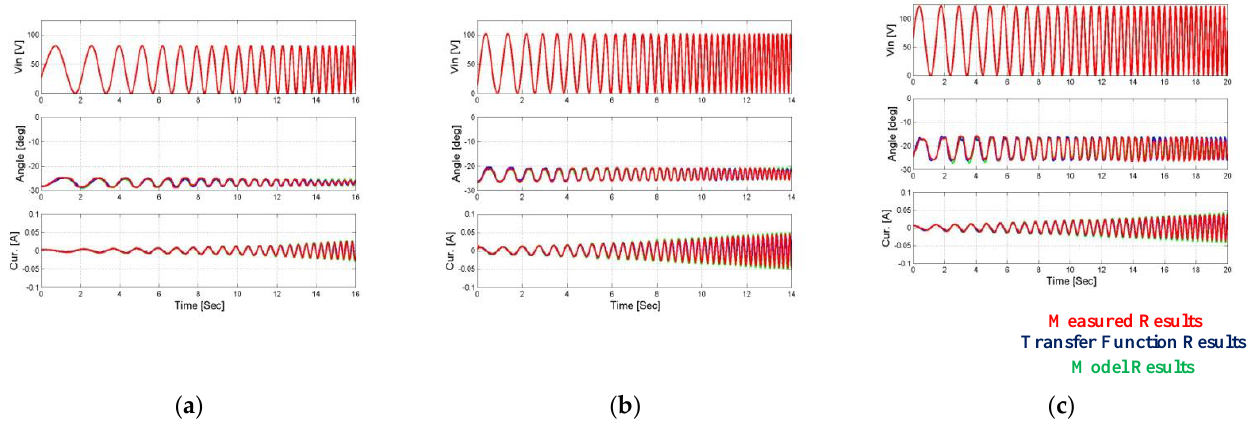
Figure 19. Comparison of uniform transfer function results ’ model results vs. measured output results when the second load is applied. ( a ) Vin = 80 V, ( b ) Vin = 100 V, and ( c ) Vin = 120 V.